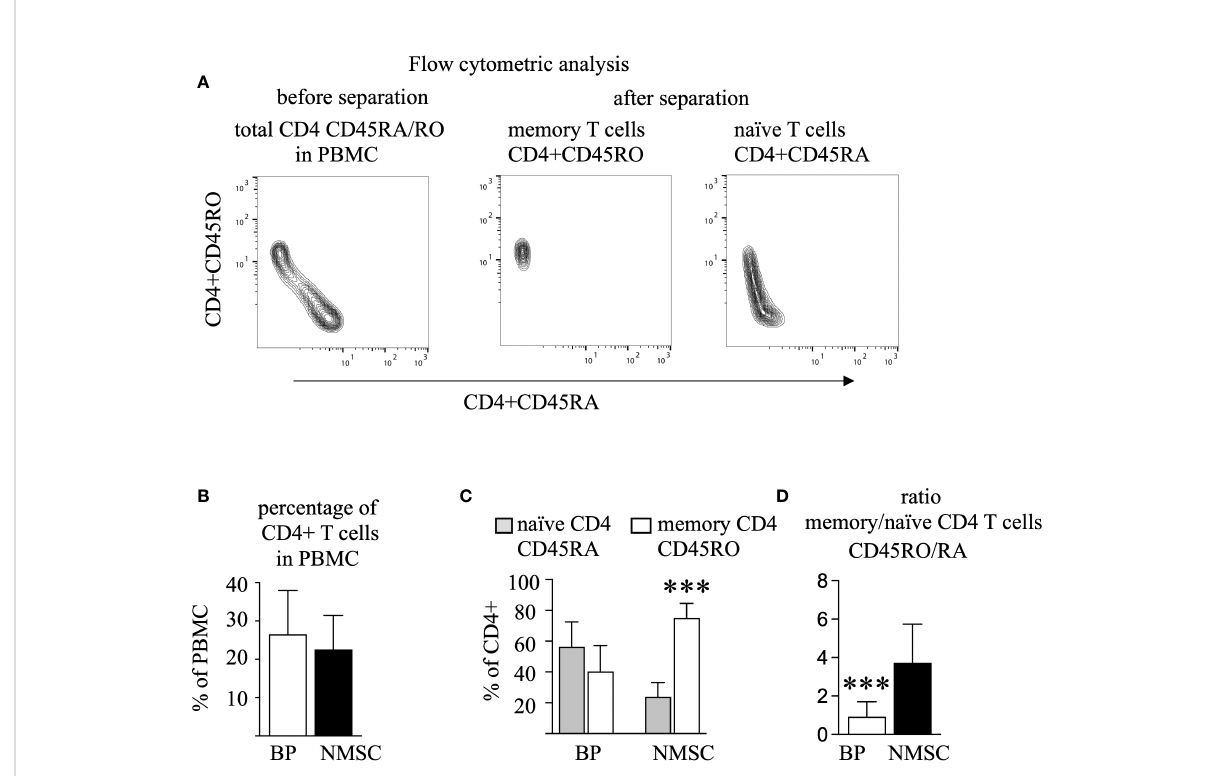
FIGURE 1 The number of memory T cells prevails in NMSC patients. PBMC from BP and NMSC patients were sorted for CD4 CD45RA and CD45RO T cells. (A) The gating strategy of one typical example is shown. Because CD45RO T cells were sorted by negative selection (middle panel), they appear as a speci fi c population in contrast to the CD45RA population (right panel). (B) The size of the circulating CD4 T cell population is similar in BP and NMSC patients as shown as percentages of PBMC (Data are mean ± SD, p=0.43, not signi fi cant (n. s.) Mann-Whitney test). (C) NMSC patients harbor signi fi cantly more CD45RO T cells (Data are mean ± SD, ***p < 0.001, 2-way ANOVA with turkeys ’ multiple comparison test). (D) The ratio of the CD45RO/RA population is signi fi cantly lower in BP patients. (Data are mean ± SD, ***p < 0.001, Mann-Whitney U test), (in B – D , n=14 (BP) and n=6